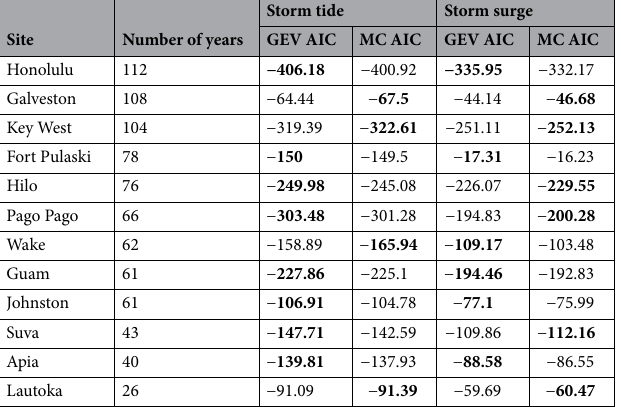
Table 1. AIC estimates for the tide gauge GEV and MC EVD fits. Bold numbers indicate lower (more negative) AIC values (i.e. better models).